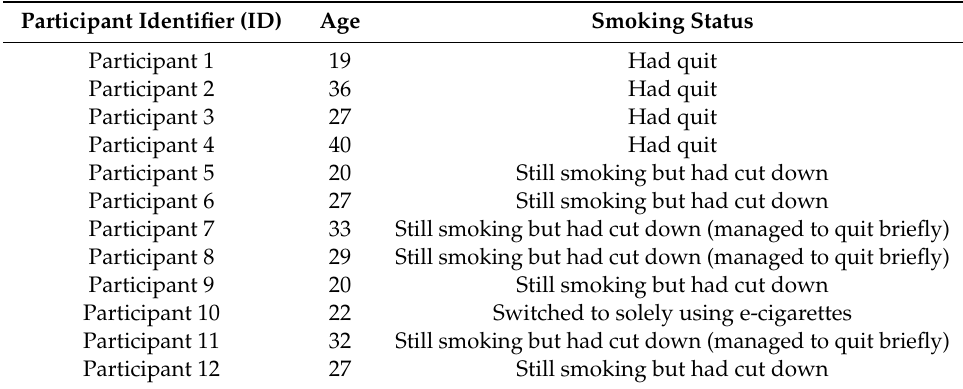
Table 1. Smoking status of participants at time of